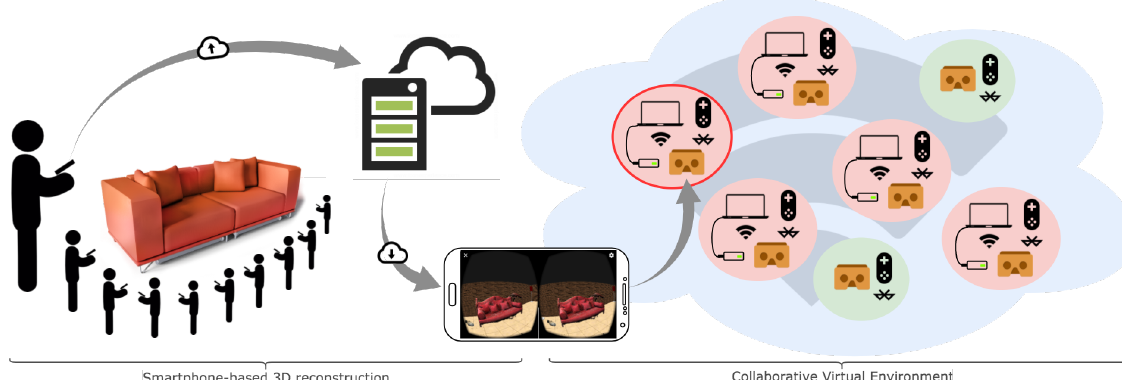
Figure 1. Diagram of a collaborative VR setup comprised of a smartphone-based 3D reconstruction step (left-hand side) and an immersive collaborative experience (right-hand side). Automatically selected images from a smartphone’s camera feed are sent to a reconstruction server that produces the 3D model of a scanned object. This 3D model can be imported in an immersive VR environment where multiple users can collaborate. The collaborative virtual environment is based on a client-server architecture. The server is represented as a red contour. The user that starts a VR session is the server. Clients connect to the server either as active or passive users, red and green colours on the right-hand side, respectively. A Leap Motion (orange VR icon inside each circle) is connected to each computer and hand-tracking data is transmitted to an associated Cardboard device. Users can interact with virtual objects in the same VR space and see each other’s